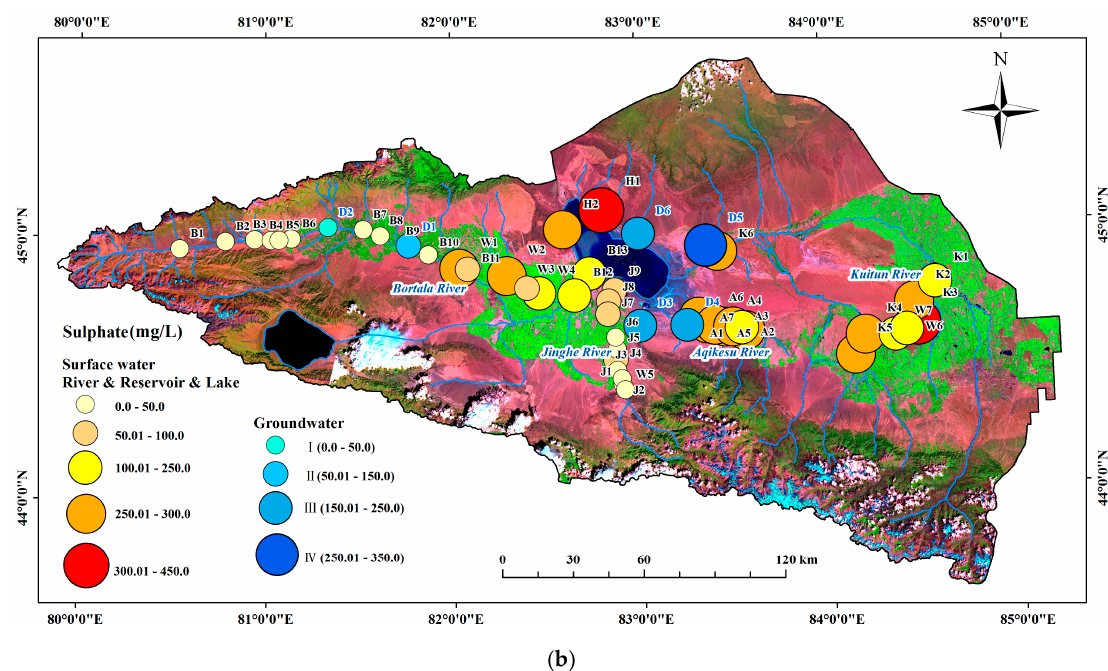
Figure 8. Spatial distribution of conventional water quality indicators (total hardness ( a ) and sulfate ( b )).